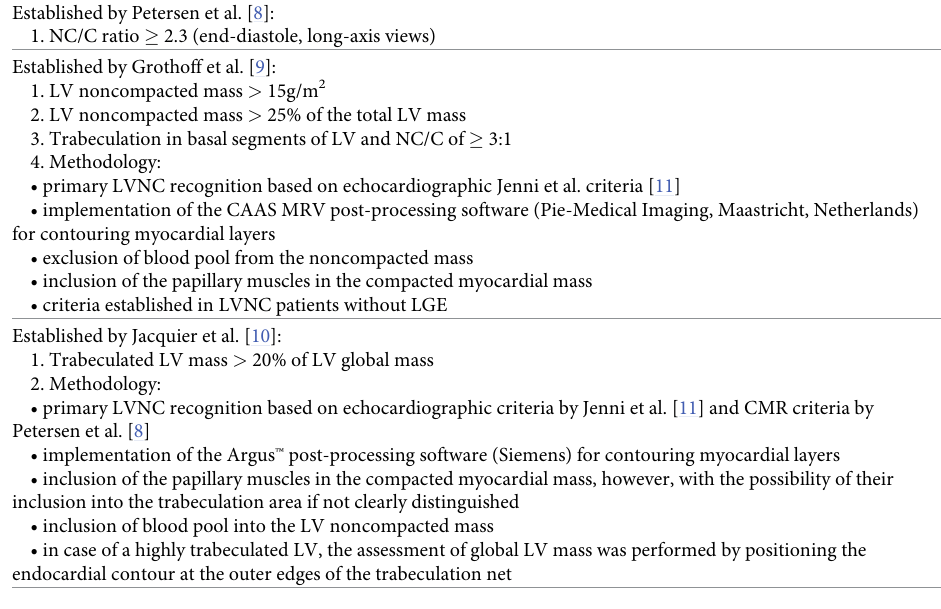
Table 1. Review of the most popular left ventricular noncompaction (LVNC) recognition criteria using cardiac magnetic resonance (CMR) examination. Established by Petersen et al. [8]: 1. NC/C ratio � 2.3 (end-diastole, long-axis views) Established by Grothoff et al. [9]: 1. LV noncompacted mass > 15g/m